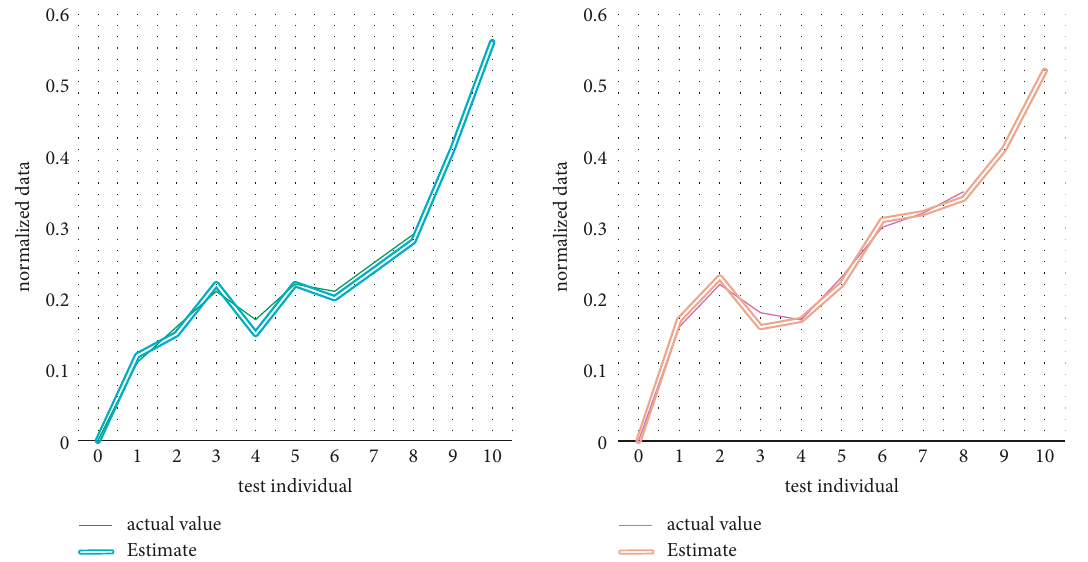
Figure 1: BP algorithm results of neck circumference and small shoulder